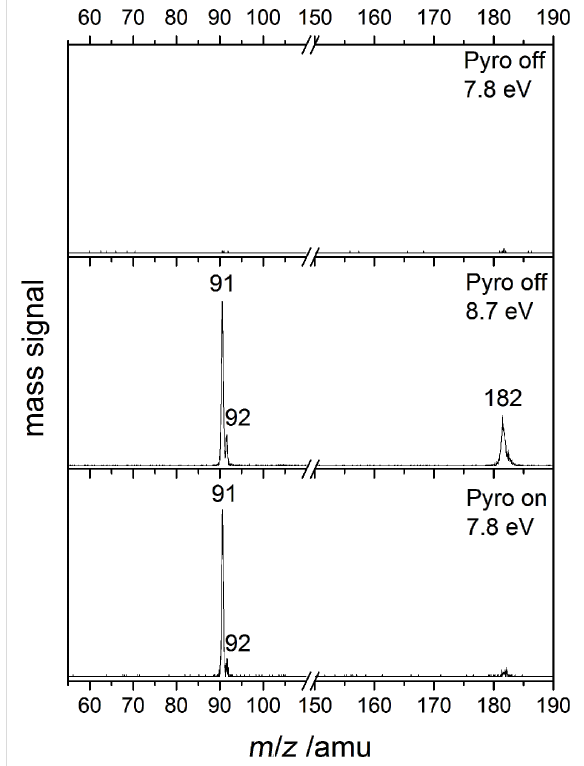
Figure 3: Threshold photoelectron spectrum of tropyl (black line). The Franck–Condon simulation (red line) is based on the computed stick spectrum (blue sticks) convoluted with 30 meV FWHM